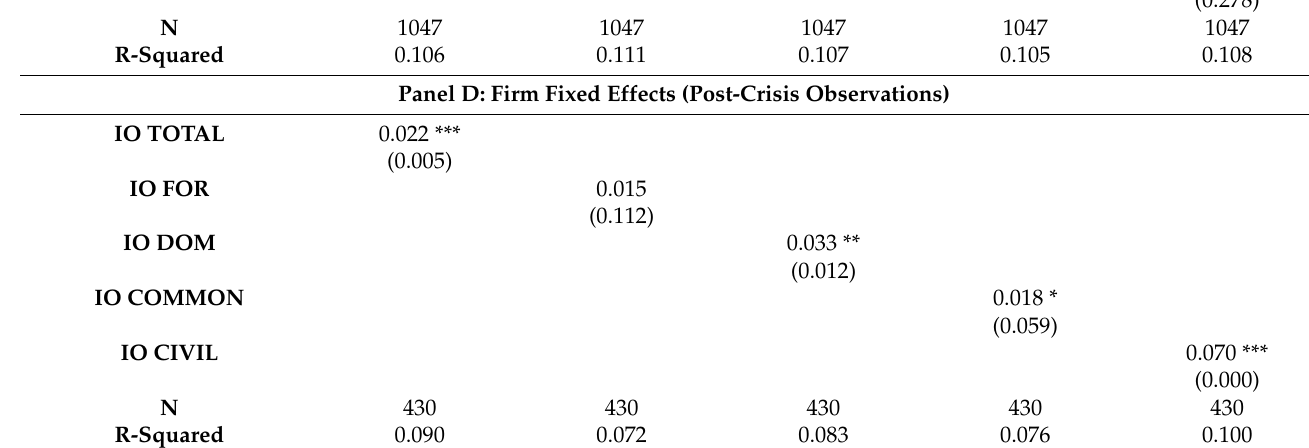
Panel C: Firm Fixed Effects (Crisis Observations)